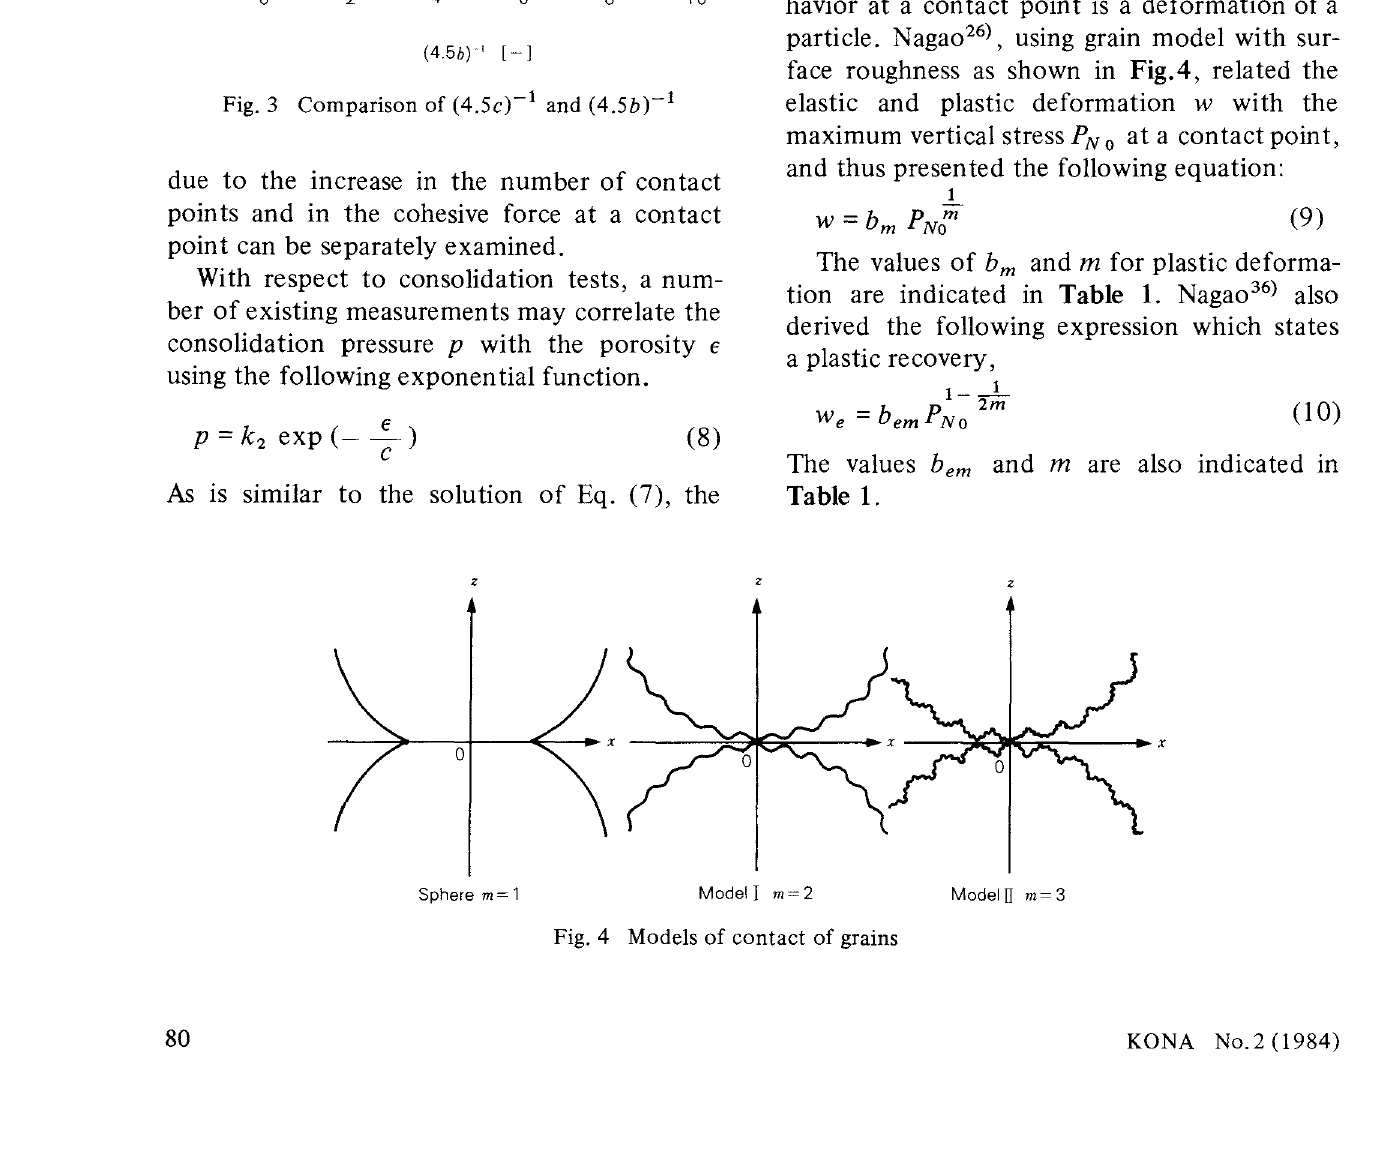
Fig. 3 Comparison of (4.5c)- 1 and (4.5b)- 1